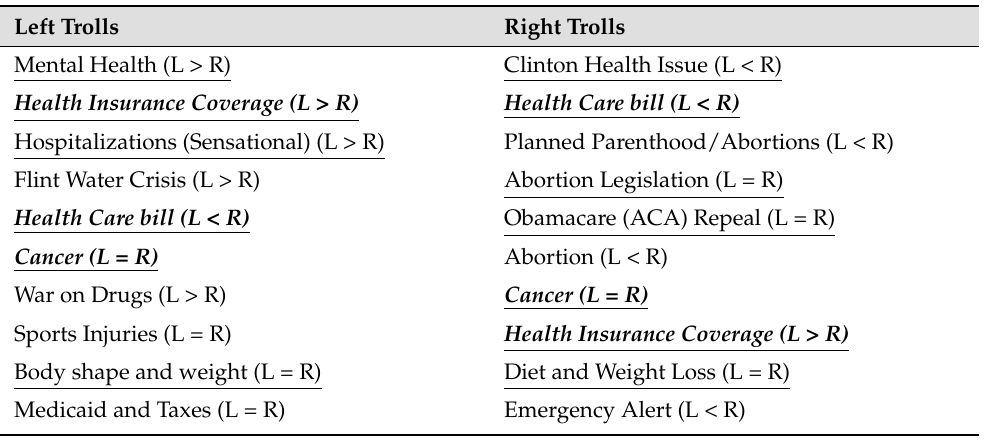
Table 3. Top 10 topics of left and right trolls based on the average weight of each topic per tweet. The three common topics are shown in bold-italic format. Topics that are underlined are also among the overall top 10 topics in Figure